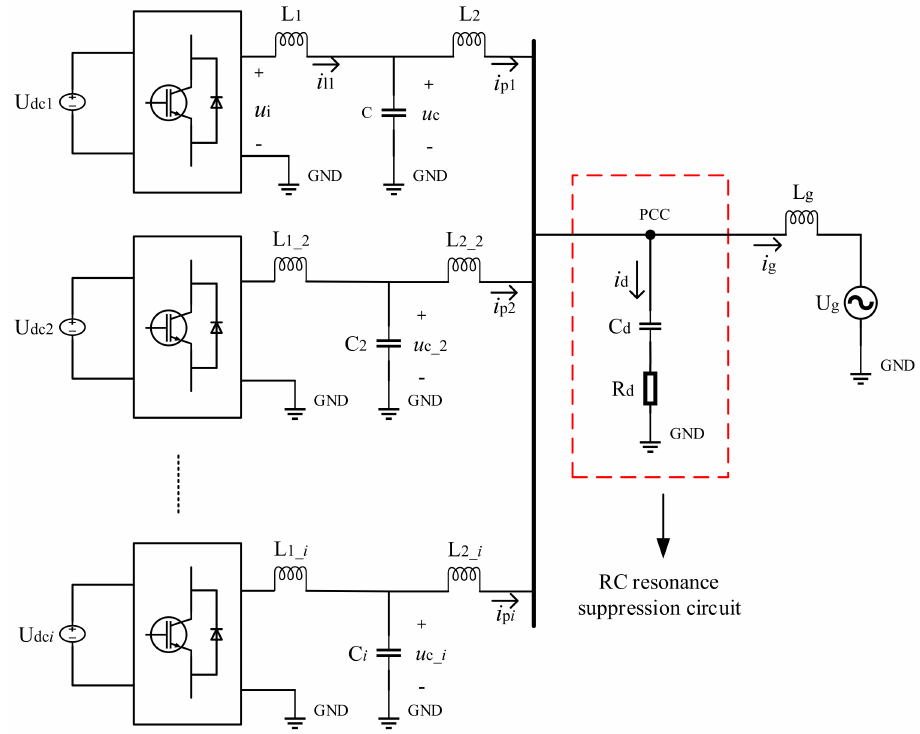
Figure 7. RC resonance suppression circuit schematic